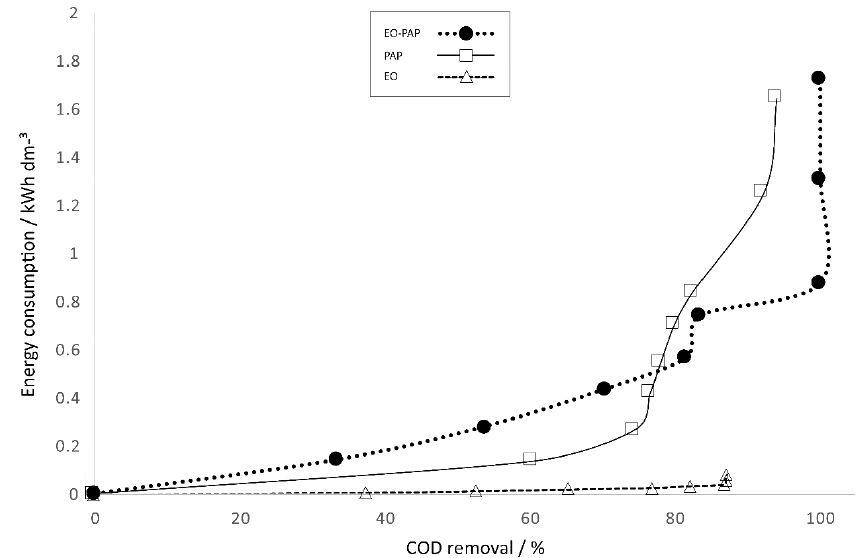
Figure 10. COD removal efficiency for azo dye Carmoisine (5 ppm) as a function of energy consumption. ( △ ) EO, ( ) PAP and ( • ) EO – PAP sequenced processes. The current density was 30 mA·cm − 2 , and the pH of the sample was adjusted to 5.2. The treated volume was 1.1 L.